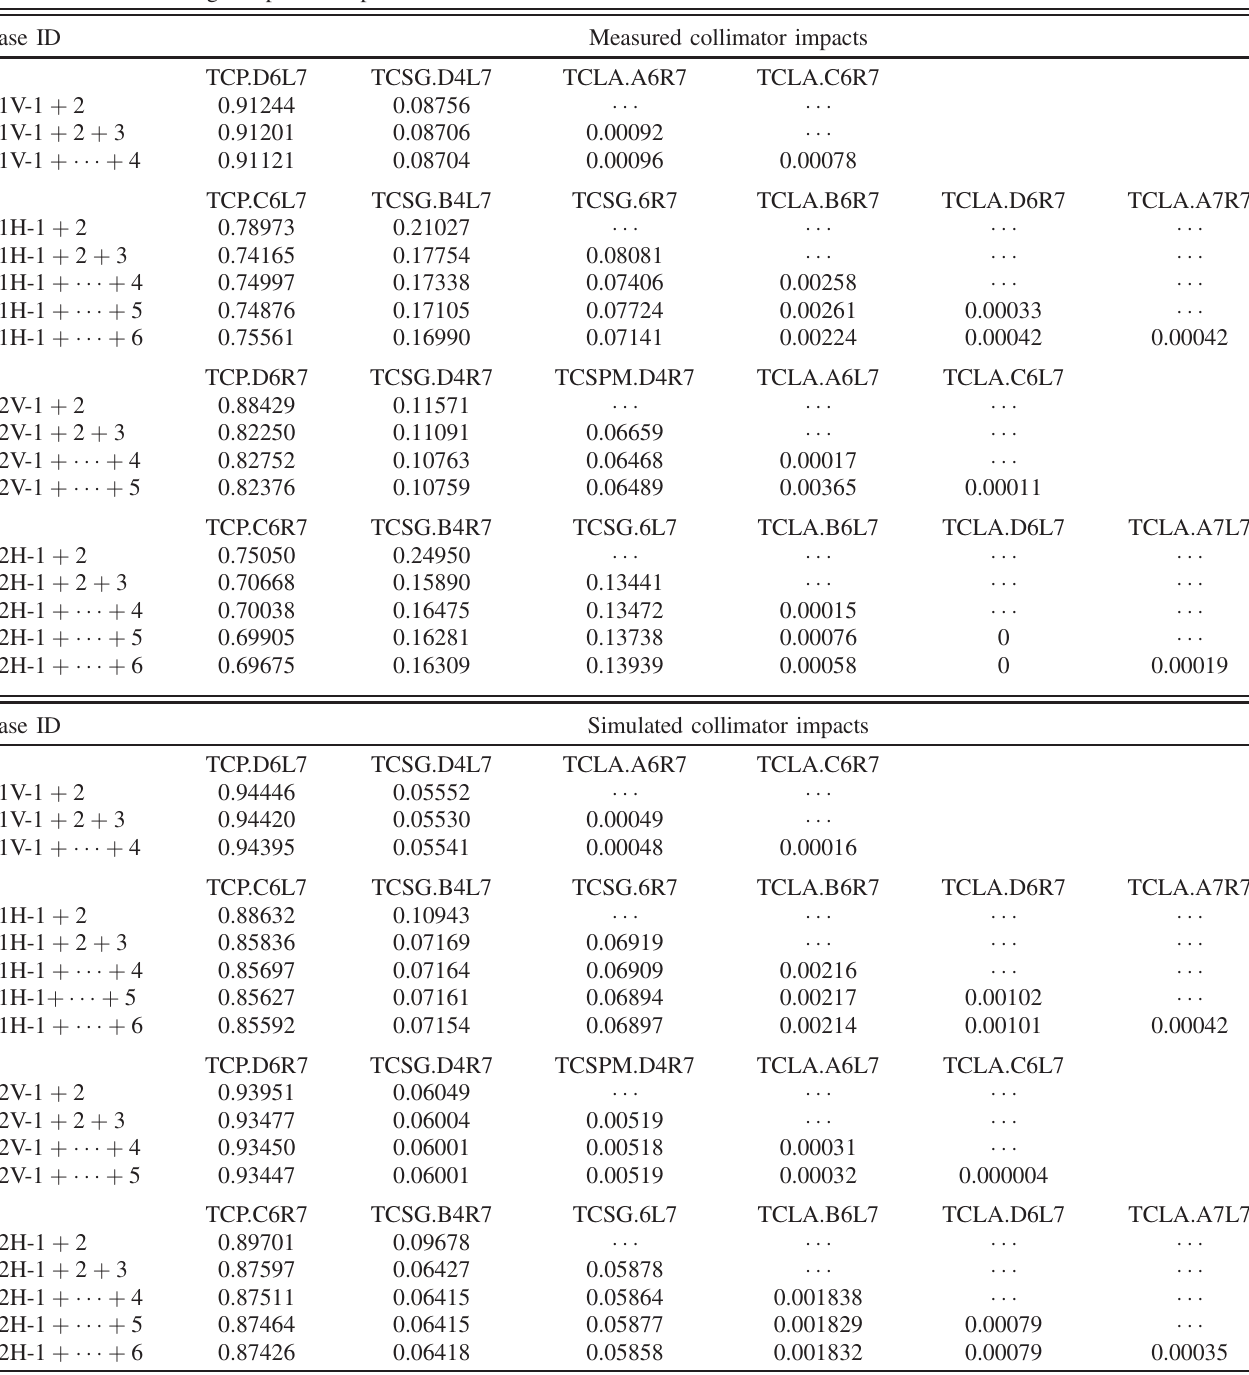
TABLE VII. Percentage of proton impacts measured and simulated from the combined cases of closed